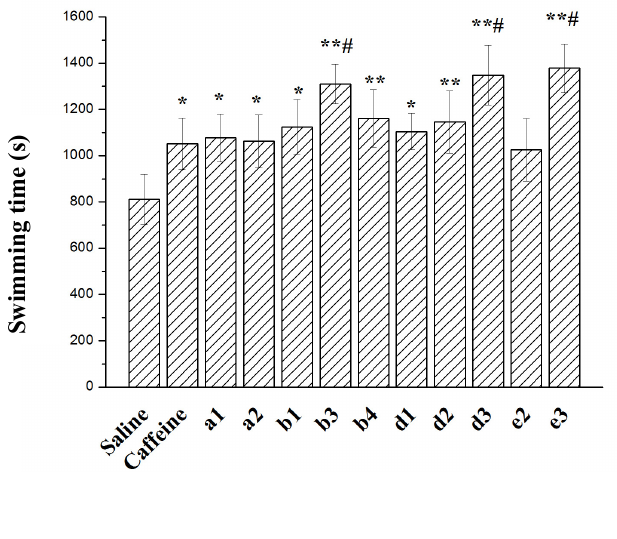
Figure 4. Effects of compounds on the forced swimming time. ** p < 0.01 compared with the saline group, * p < 0.05 compared with the saline group, # p < 0.05 compared with the caffeine